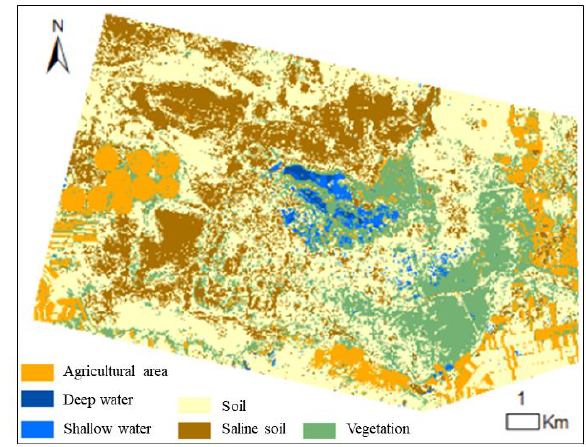
Figure 5. a) Thematic map produced from Planetscope with rule based classifier.